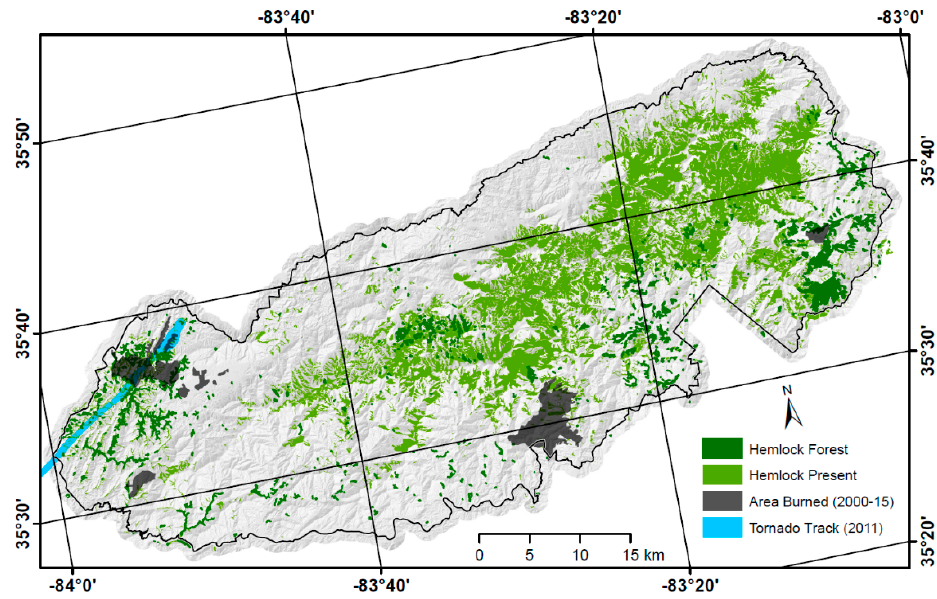
Figure 9. Areas of known blowdown, fire and insect-induced tree mortality within Great Smoky Mountains National Park, 2000–2015.